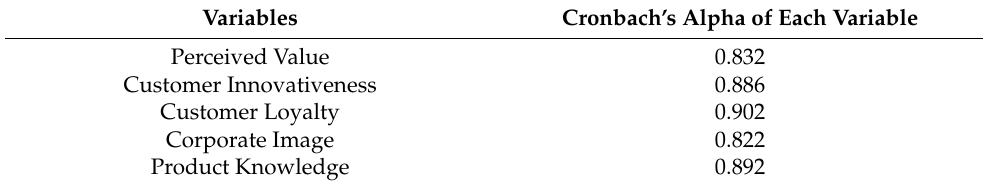
Table 2. Cronbach’s alpha of each variable.